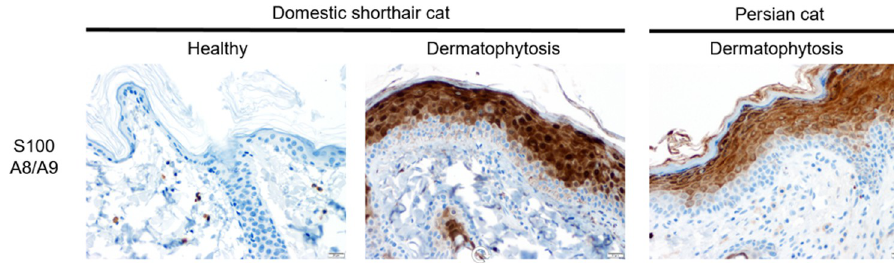
Fig 5. S100A8/S100A9 (calprotectin) immunohistochemistry performed on feline skin with and without dermatophytosis. No immunolabeling of the epidermis was observed in healthy domestic shorthair cats. Both domestic shorthair cats and Persian cats with dermatophytosis exhibited strong immunolabeling of the epidermis, excluding the basal cell layer. S100A8/S100A9 immunohistochemistry.